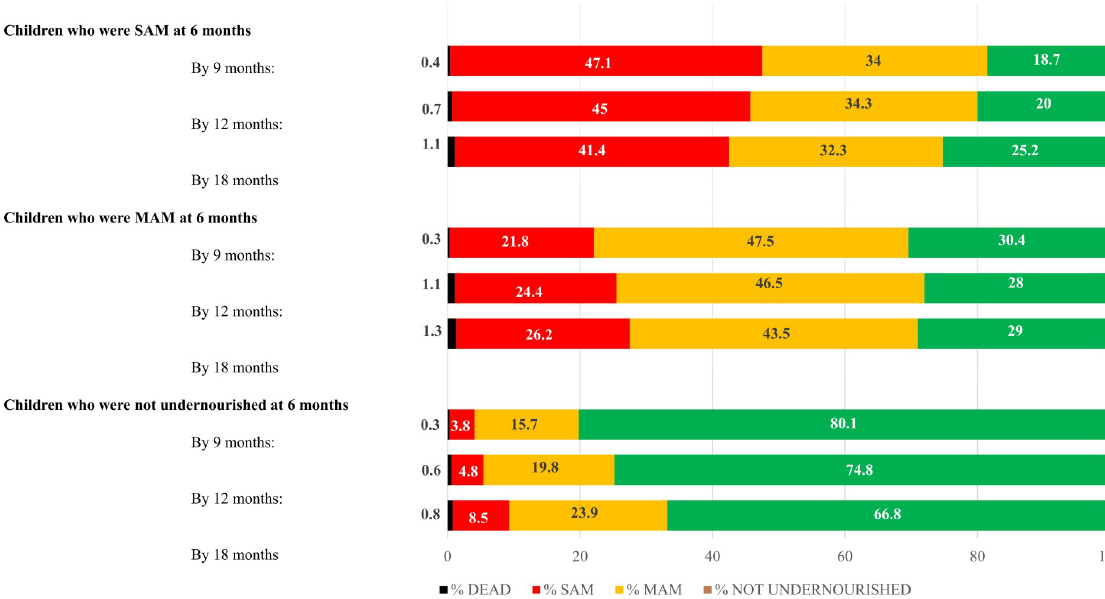
Fig 2. Long-term outcomes for children with and without acute malnutrition at 6 months, using a data set with multiple imputation. MAM, moderate acute malnutrition; SAM, severe acute malnutrition.